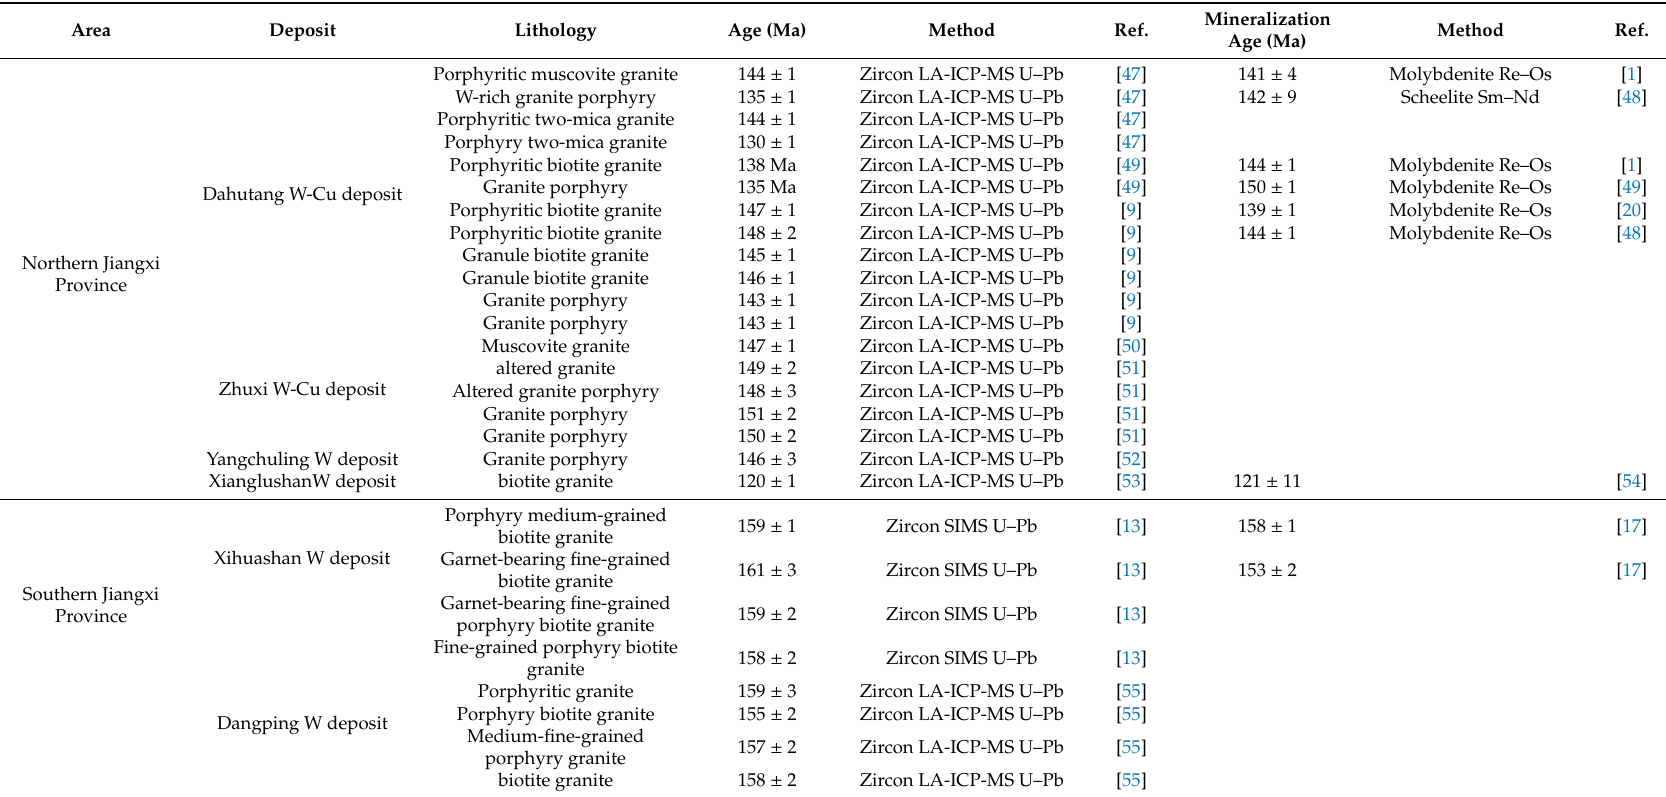
Table 3. Yanshanian granites and related W deposits in Jiangxi Province selected for this